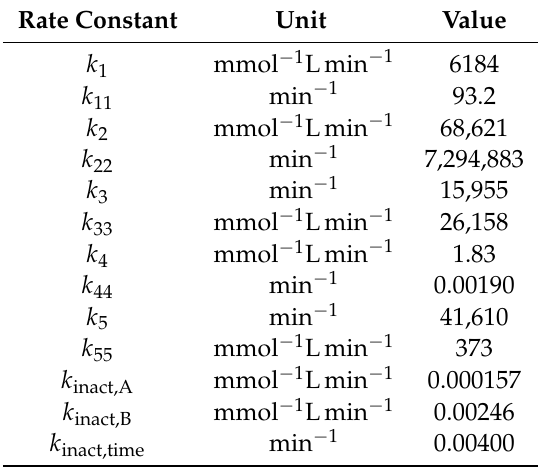
Table 2. Kinetic parameters for the Pf BAL kinetic